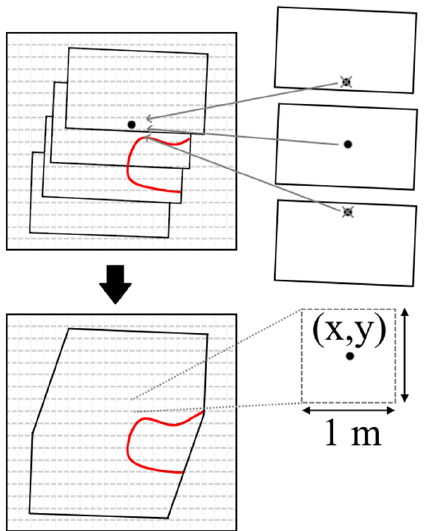
Figure 6. An exaggerated example of the gridding process on an idealized feature (red line). The dashed gray lines indicate the grid of cells. The left grids show the before and after representation of imagery during the gridding process. The three frames on the top right exemplify the process of determining what value should be in the final cell. Example shown for a 1 m pixel size.